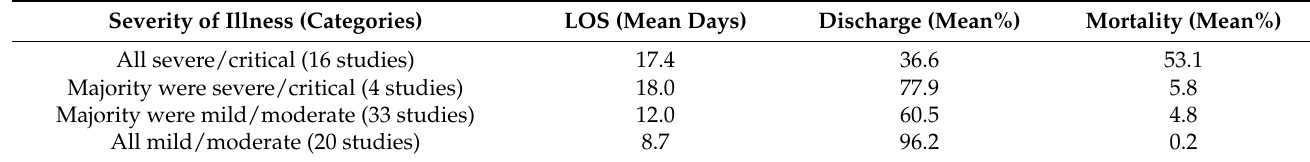
Table 4. Severity of illness and health outcomes.